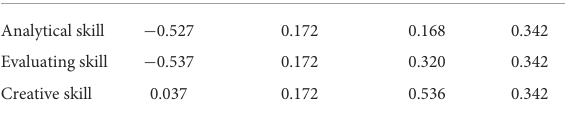
TABLE 3 Skewness and kurtosis values of reading comprehension tests. Test Skewness Standard error Kurtosis Std. error